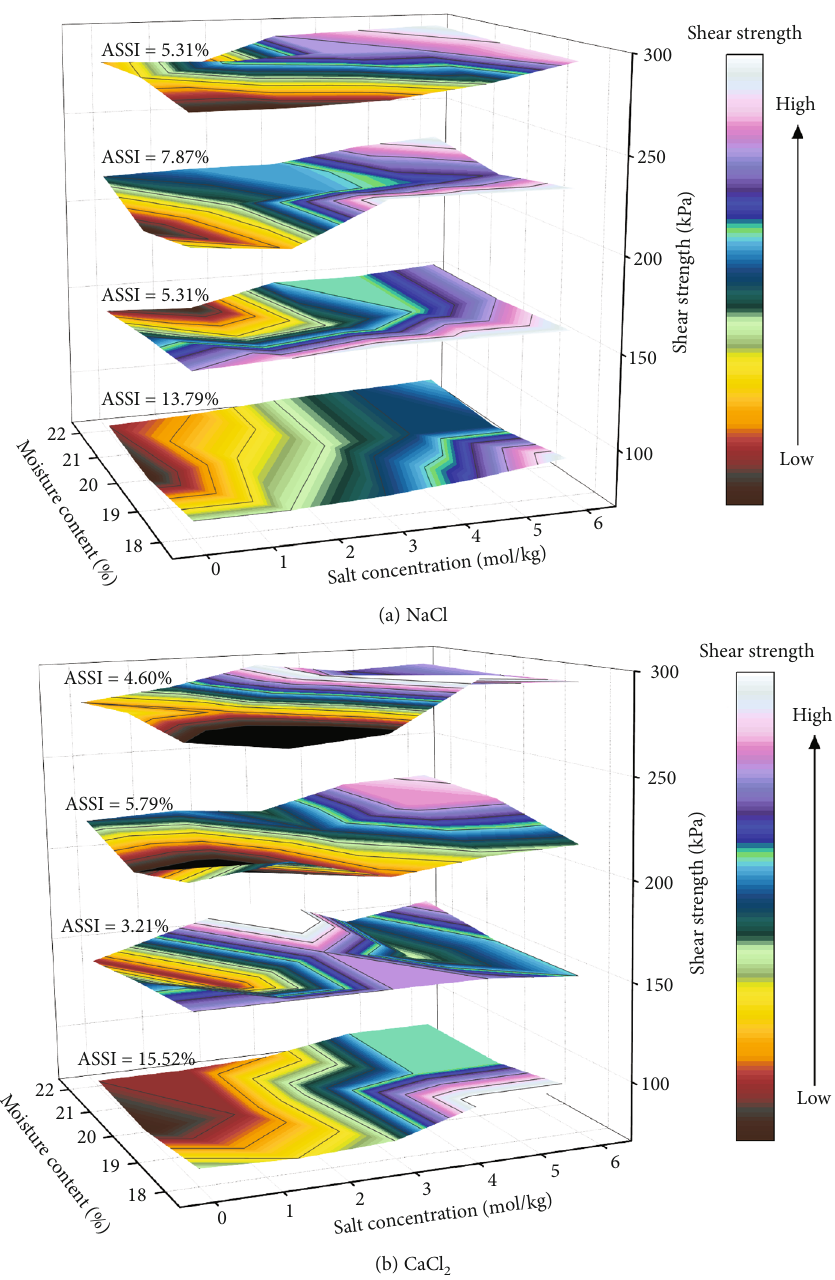
Figure 6: The relationship between shear strength and salt concentrations under di ff erent moisture contents and di ff erent vertical stresses (ASSI: average shear strength increment with the salt concentration increasing from 0mol/kg to 6mol/kg under the same vertical